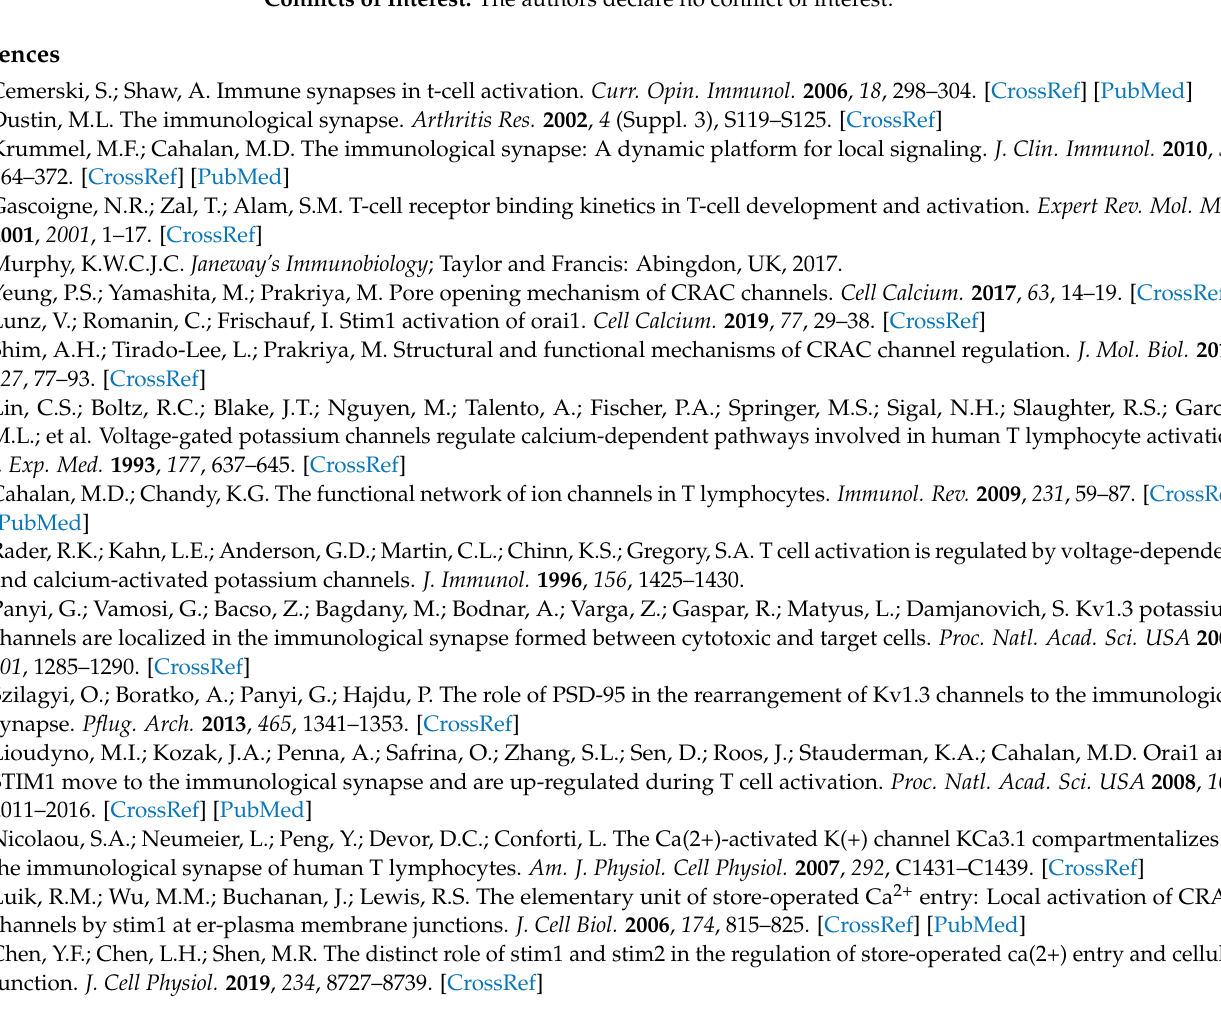
Figure S6: Distribution of the accumulation ratio (AR). Figure S7: CD3 and CD28 expression in different cell